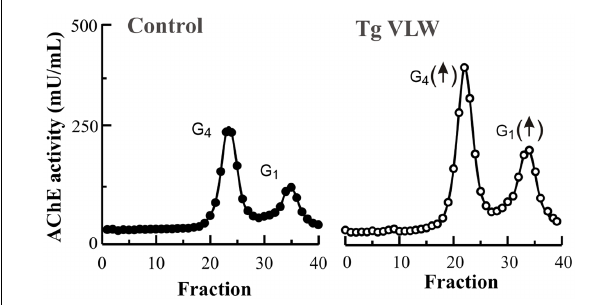
FIGURE 5 |All molecular forms ofAChE are increased in the brain of a transgenic mice model of P-tau over-expression. In a transgenic mice (TgVLW; open circles) expressing human tau mutations causing frontotemporal dementia and parkinsonism linked to chromosome 17 (FTDP-17), both the major cholinergic tetramers G 4 AChE and light monomeric forms G 1 AChE activities were higher compared to age-matched control-littermate mice (closed circles; 5months